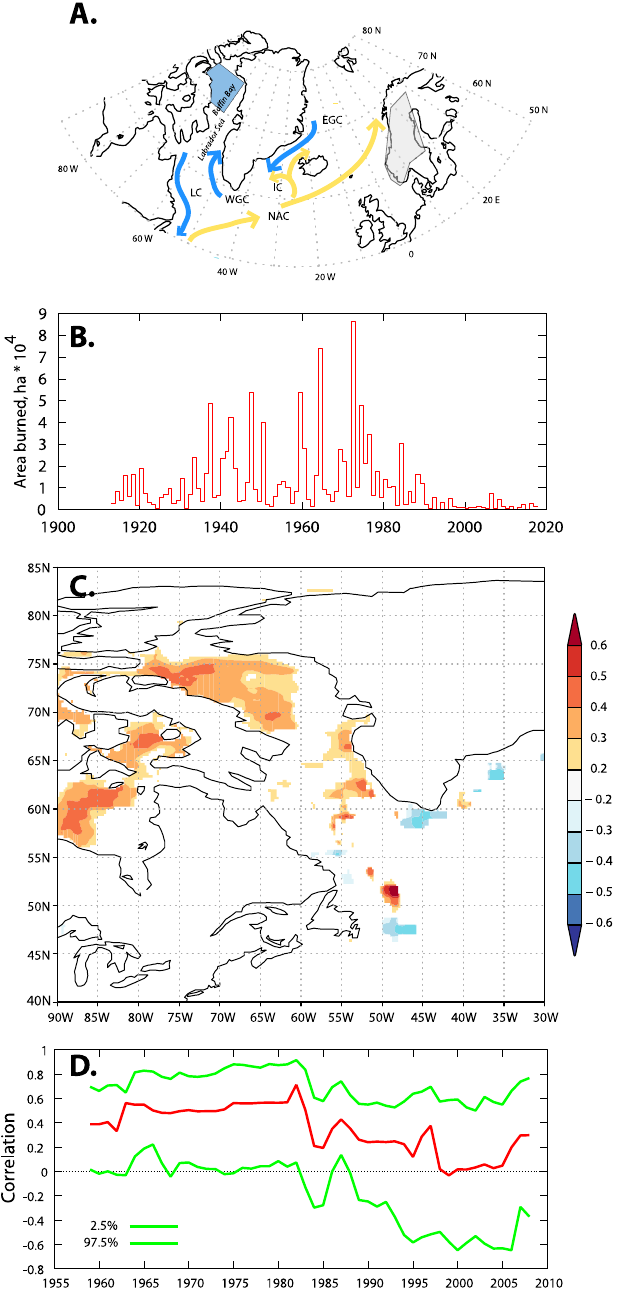
Figure 3. Field correlations between the sea ice content over 70–75 N and 80–60 W and 3-month SPEI Figure 1. The study region, and the relationship between the Scandinavian fire record (detrended index for April − May ( A ), May–June ( B ), June–July ( C ), and July–August ( D ). Areas with significant the total sum of burned areas in the northern Sweden and Norway) and estimates of sea ice cover correlation ( p < 0.10) are colored. The value and direction of correlation are shown by the color scale. from ERA5 reanalysis dataset over 1950–2017. ( A ) The study region with the marked sections of the Baffin Bay (blue color) and the Scandinavia (gray color), which were studied. NAC, North Atlantic Current; IC Irminger Current; EGC, East Greenland Current; WGC—West Greenland Current; LC, Labrador Current. ( B ) Cumulative chronology of burned areas for northern Sweden and Norway. ( C ) Field correlations over the Baffin–Labrador Sea area. Areas with significant correlation ( p < 0.10) are colored. The value and direction of correlation are indicated by the color scale. ( D ) Running correlations (time frame for moving correlation analysis is 20 years) between the Scandinavian fire record and the area with the highest correlation values on A (70–75 N and 80–60 W). Green lines indicate bootstrap-derived 0.95 confidence